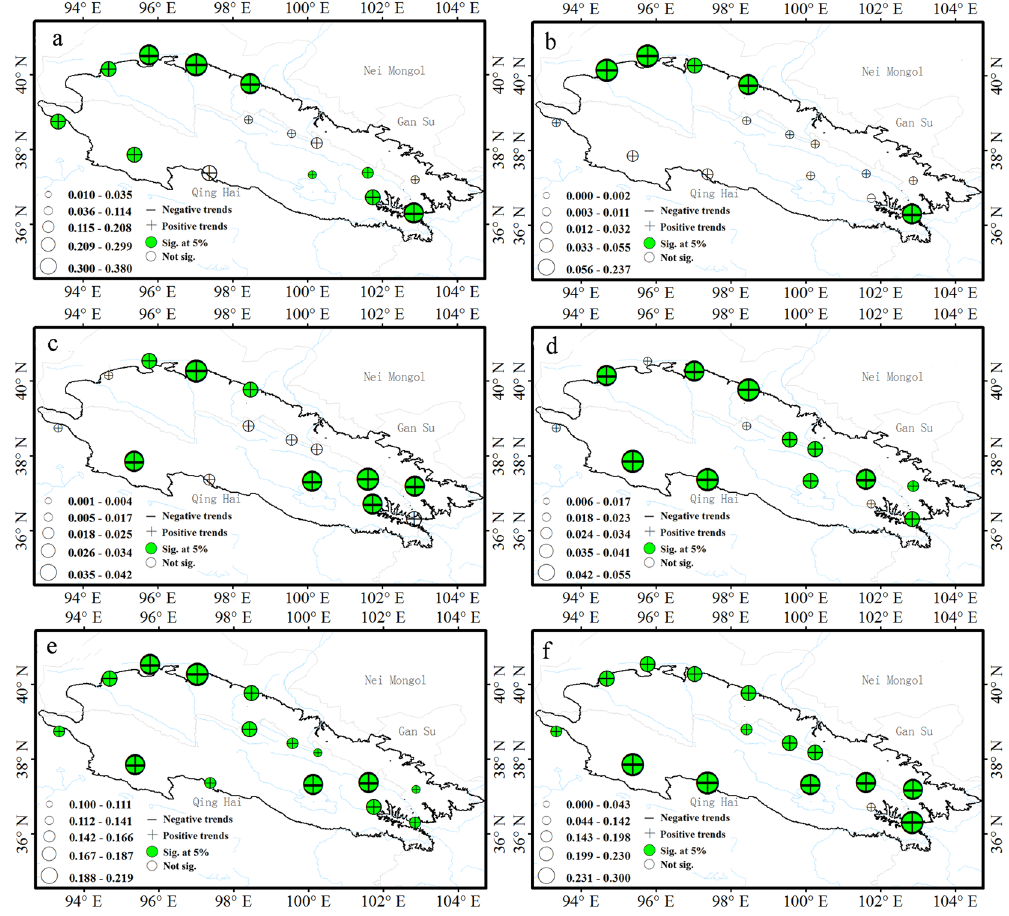
Figure 2. Spatial pattern of indices of warm-temperature extremes. Warm indices: summer days ( a ), tropical nights ( b ), warmest days ( c ), warmest night ( d ), warm days ( e ), warm nights ( f ). For description of indices, see Supplementary Table S1. The size of the circles is the degree of changing. Positive trends are shown as pluses, negative trends as minuses. A green symbol indicates significance at the 5%; a white symbol represents non- significant trends. The maps are generated with Arc Map Ver 10.1 (http://www.esri.com/software/arcgis/arcgis-